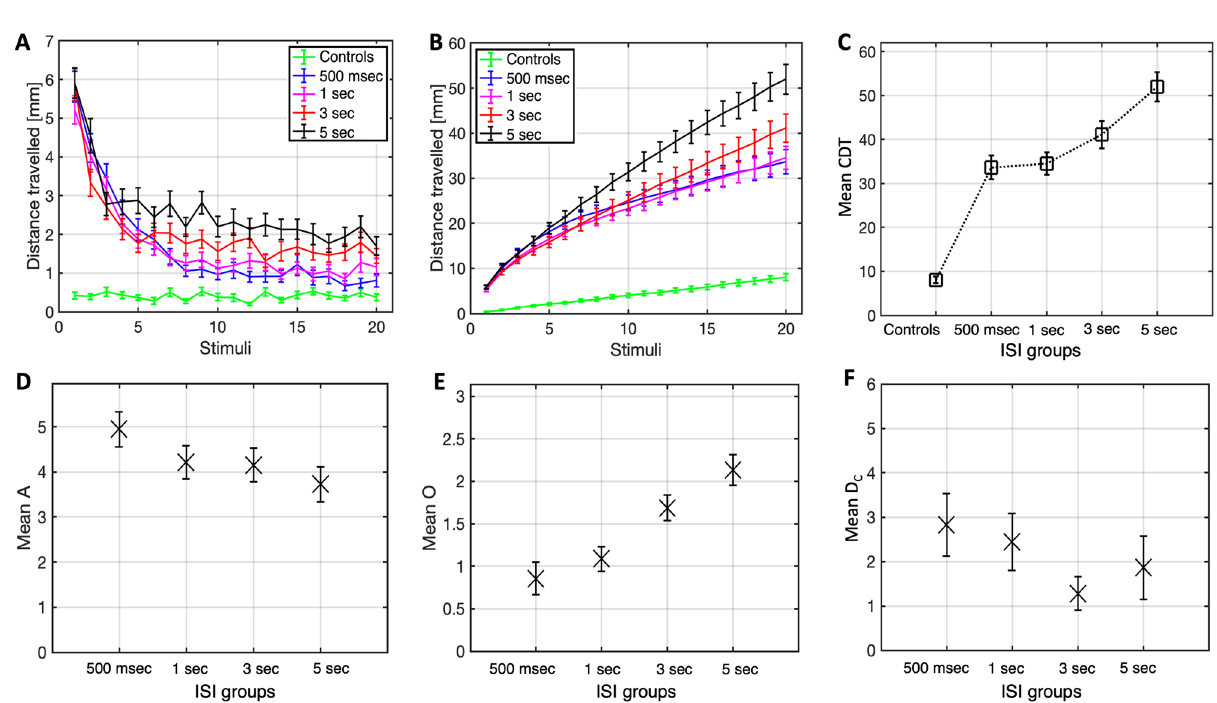
Figure 5. Plots of the distance travelled (M ± 1 SE) at each stimulus ( A ), cumulative distance travelled over successive stimuli ( B ), and mean CDT boxplots ( C ) for all the ISI duration groups and the control group. Boxplots for the amplitude ( D ), offset ( E ) and decay constant ( F ) of 250 bootstraps (M and SE), for all ISI duration